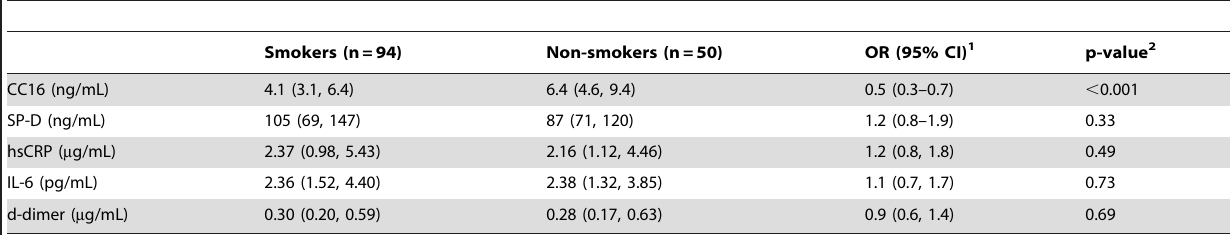
Table 2. Median (IQR) levels of Surfactant Protein-D (SP-D), Club Cell Protein 16 (CC16), high-sensitivity C-reactive protein (hsCRP), Interleukin-6 (IL-6), and d-dimer levels by baseline smoking status (cases and controls combined).